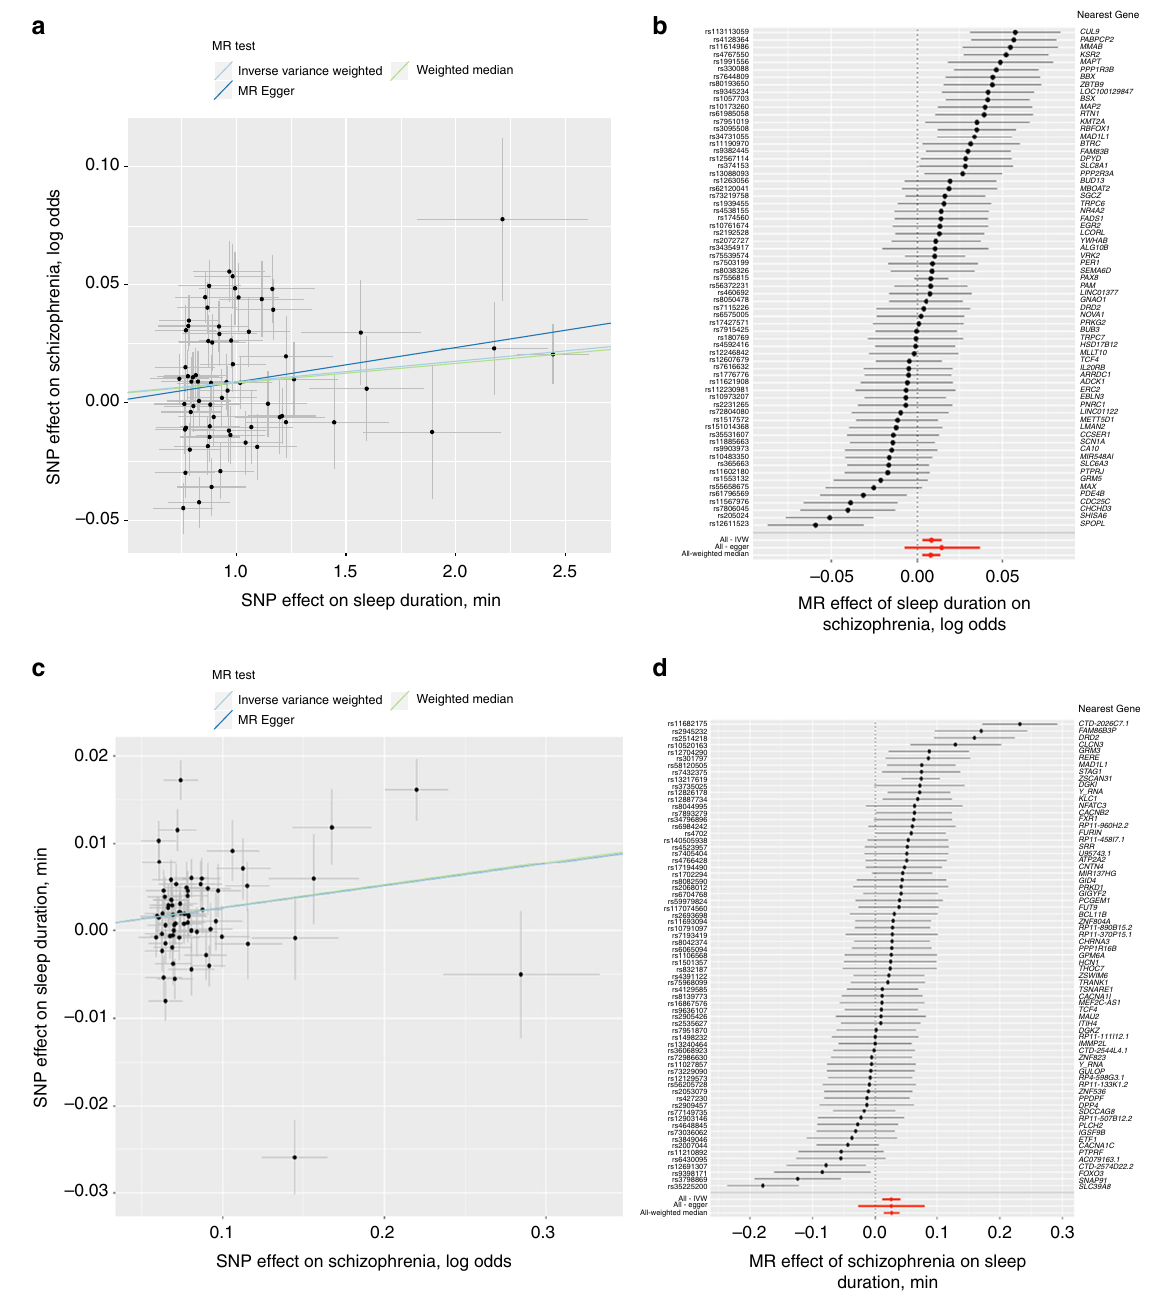
Fig. 4 Bidirectional causal relationship of sleep duration with schizophrenia using Mendelian randomization. Association between single-nucleotide polymorphisms (SNPs) associated with sleep duration and schizophrenia ( a ) or SNP associated with schizophrenia and sleep duration ( c ) and forest plots show the estimate of the effect of genetically increased sleep duration on schizophrenia ( b ) or increased risk of schizophrenia on sleep duration ( d ). Lines identify the slopes for three Mendelian randomization (MR) association tests ( a , c ). Forest plots show each SNP with the 95% con fi dence interval (gray line segment; error bars) of the estimate and the inverse variance weighted, MR-Egger, and weighted median MR results in